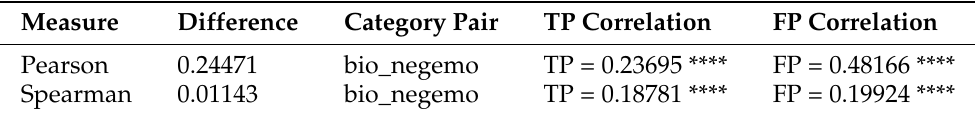
Table 31. Biological processes and Negative emotions in